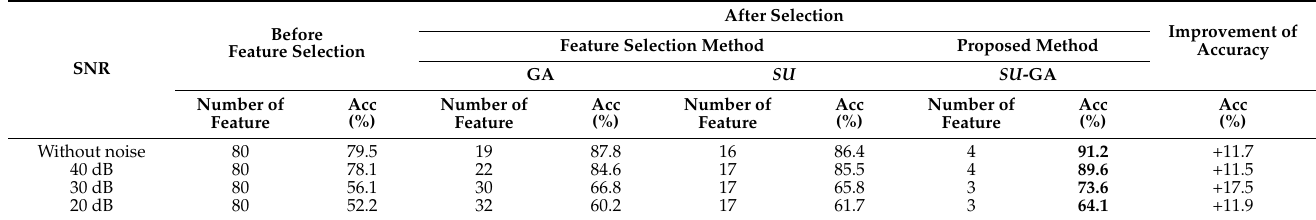
Table 5. The comparison of the number of features and the classification